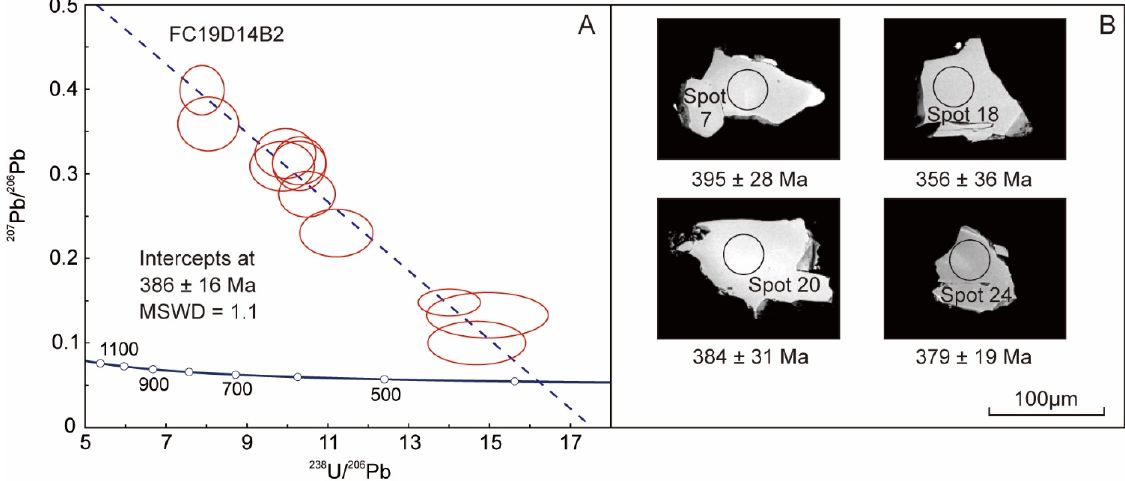
Figure 6. Tera–Wasserburg concordia plots for LA-ICP-MS data ( A ) and BSE images ( B ) of rutile in Baishugang–Wujianfang district. The location spots for the LA-ICP-MS U–Pb measurements are indicated by the black circles with ages below them.